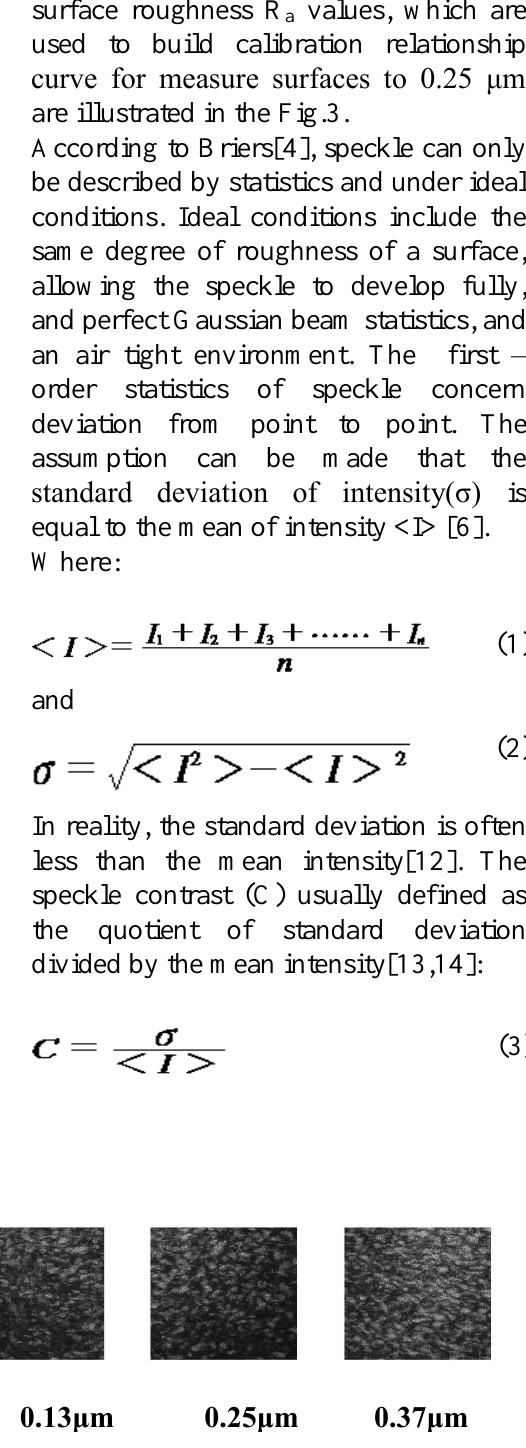
Fig.3: Specklepattern variations against the specimen surface